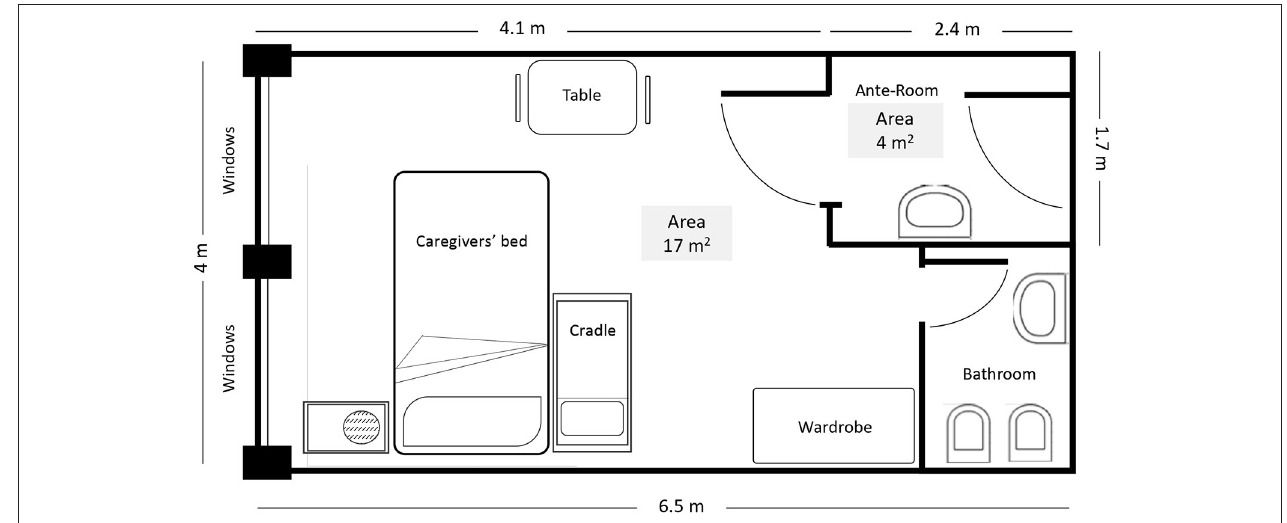
FIGURE 1 | Map of the isolation rooms where the patient and caregiver lived in close